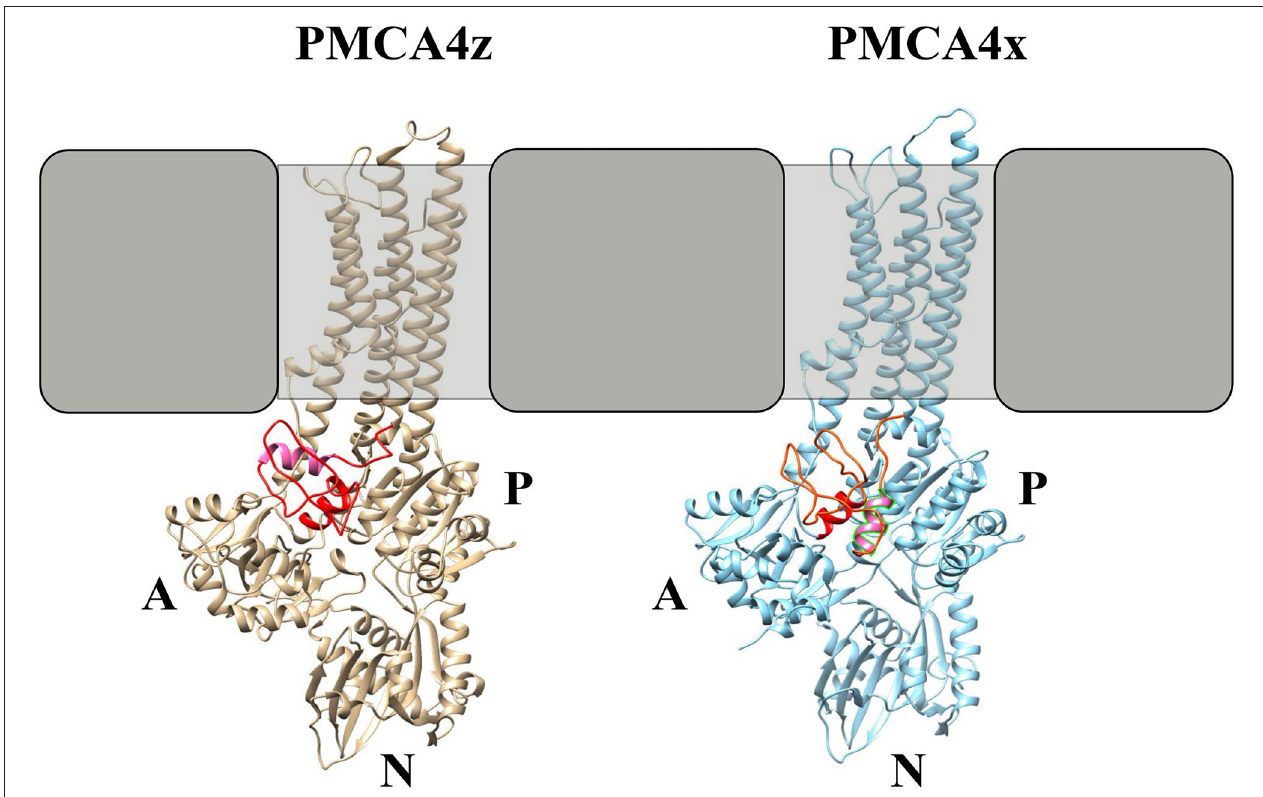
FIGURE 7 | Molecular modeling of PMCA4x and PMCA4z. Homology models of PMCA4 were obtained using the partial structure of PMCA1d (Gong et al., 2018) as a template. Only the portion of the PMCA from the amino-terminal region to the end of M6 was modeled. The tertiary structure and contact prediction model of the A-M3 linker were obtained using the RaptorX web service ( Källberg et al., 2012). The SERCA-conserved A3 helix is colored red while the putative A L helix in PMCA is colored